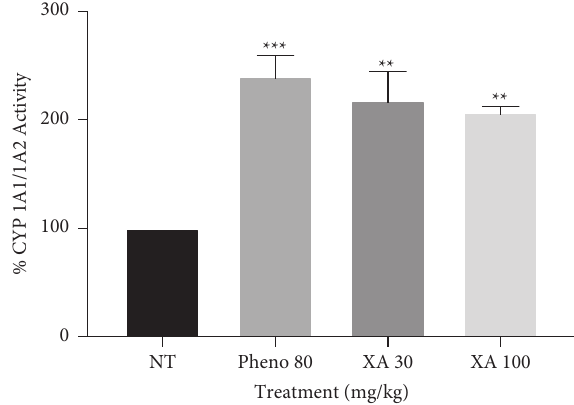
Figure 3: Effect of phenobarbitone (Pheno 80), xylopic acid low dose (30 mg/kg; XA 30), and xylopic acid high dose (100mg/kg; XA 100) on CYP 1A1/1A2 (EROD) enzyme activity. Data are presented as mean ± S.E.M. P < 0 . 01, ∗∗∗ P < 0 . 001 compared to the negative control (no treatment) group (one-way ANOVA followed by Tukey’s post hoc